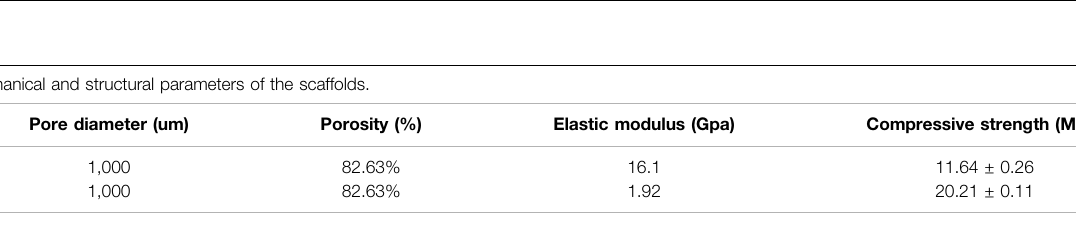
FIGURE 1 | Characterization of Ti6Al4V and Ti2448 scaffolds. Ti6Al4V scaffold in animal experiments (A1) and cellular experiments (A3) ; Ti2448 scaffold in animal experiments (A2) and cellular experiments (A4) .3D reconstruction results of Ti6Al4V(B1) and Ti2448 (B2)scaffoldsby micro-CT (B) . Surfacetopographyofthe Ti6Al4V (C1)andTi2448(C2)scaffolds,Scalebar (cid:2) 50 µm (C) .EDSresultsofTi6Al4VandTi2448showingtheirrespectiveelementalcompositionsandsurfacemorphology (D) . Water contact angle of the Ti6Al4V and Ti2448 scaffolds (E) . AFM images of Ti6Al4V and Ti2448 surfaces.